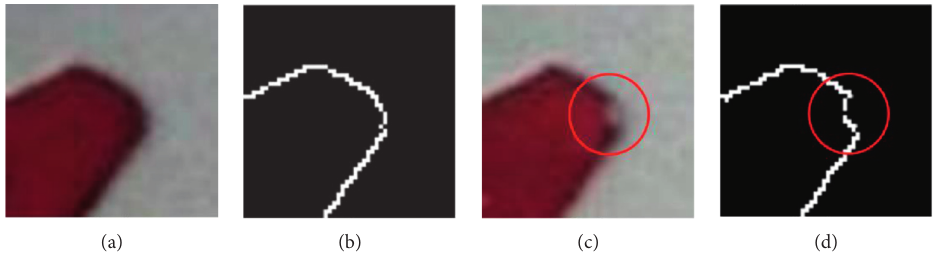
Figure 5: Edge detection effect of Canny detection operator: (a) qualified pattern; (b) qualified pattern with Canny edge detection; (c) defect pattern; (d) defect pattern with Canny edge